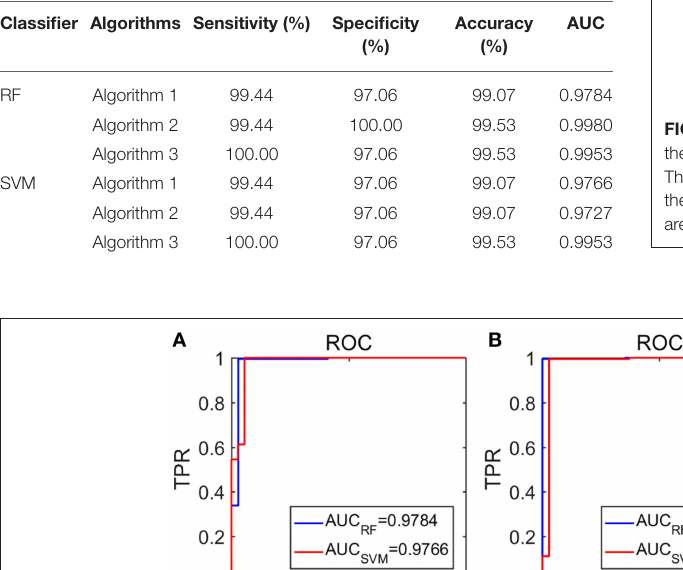
TABLE 3 | Classification performance measures.